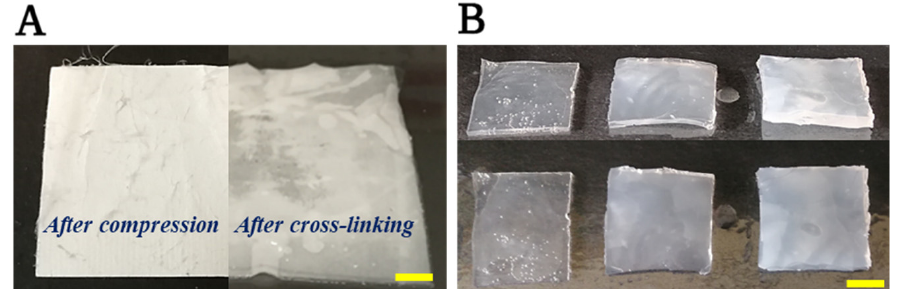
Figure 6. Electrospun PVA membrane ( A ) before (left) and after (right) chemical treatment, Hydro- gels ( B ) prepared by (low-temperature crystallisation method (left), freezing-and-thawing method (middle), hot-pressing method (right). Note: Scale bar at 0.5 cm.